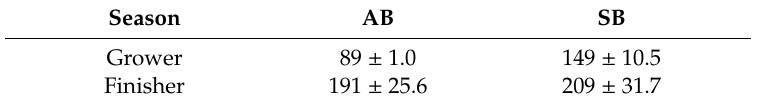
Table 1. Mean durations ( ± SD) in days of each period for autumn born (AB) and spring born (SB) bulls. Season AB SB Grower 89 ± 1.0 149 ± 10.5 Finisher 191 ± 25.6 209 ± 31.7 AB = autumn born; SB = spring